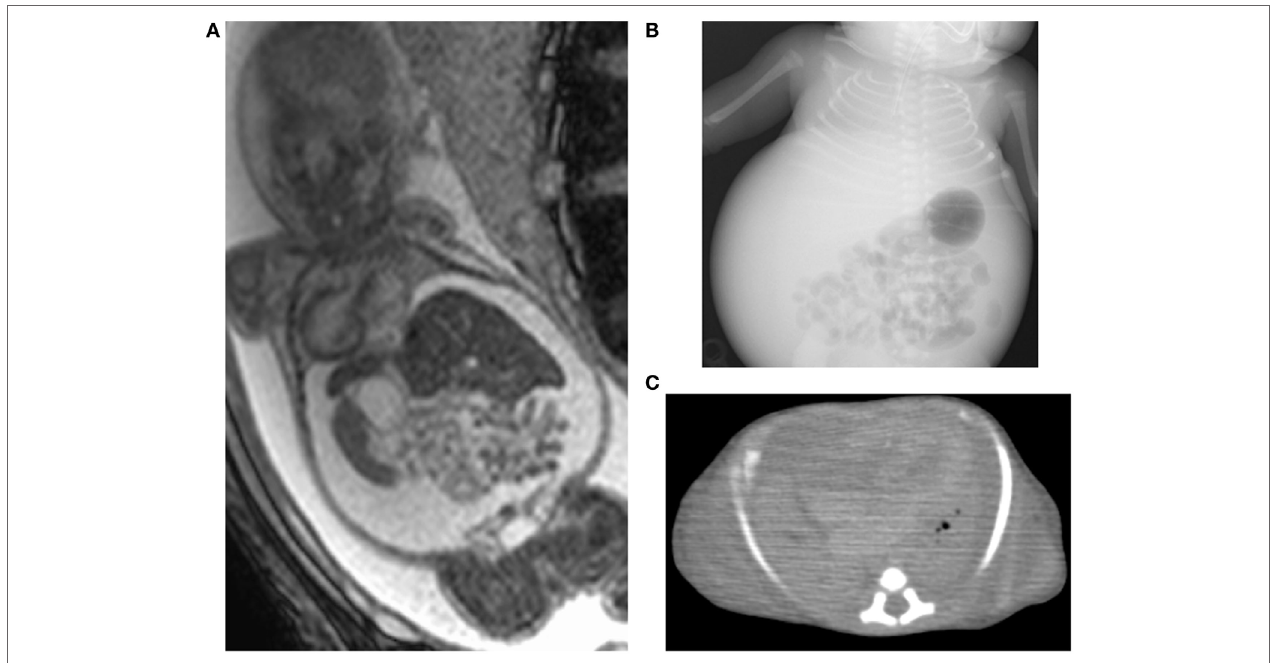
FIgURe 1 | Images of case 1. Fetal magnetic resonance imaging shows massive ascites and compressed lungs (a) . Chest X-ray (B) and postmortem chest CT (C) show pulmonary